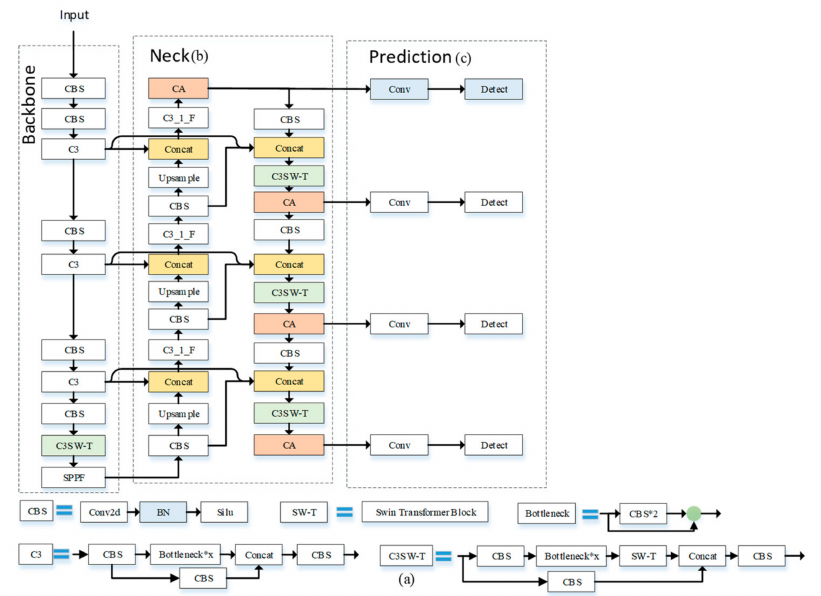
Figure 1. Network structure diagram of improved YOLOv5. (a) CSPDarknet53 with Swin Transformer Block at the Neck and end of Backbone. (b) The Neck uses a structure like BiFPN. (c) Four prediction heads use the feature maps from Coordinate Attention.